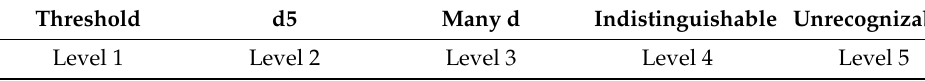
Table 3. Five levels of diagnosis.